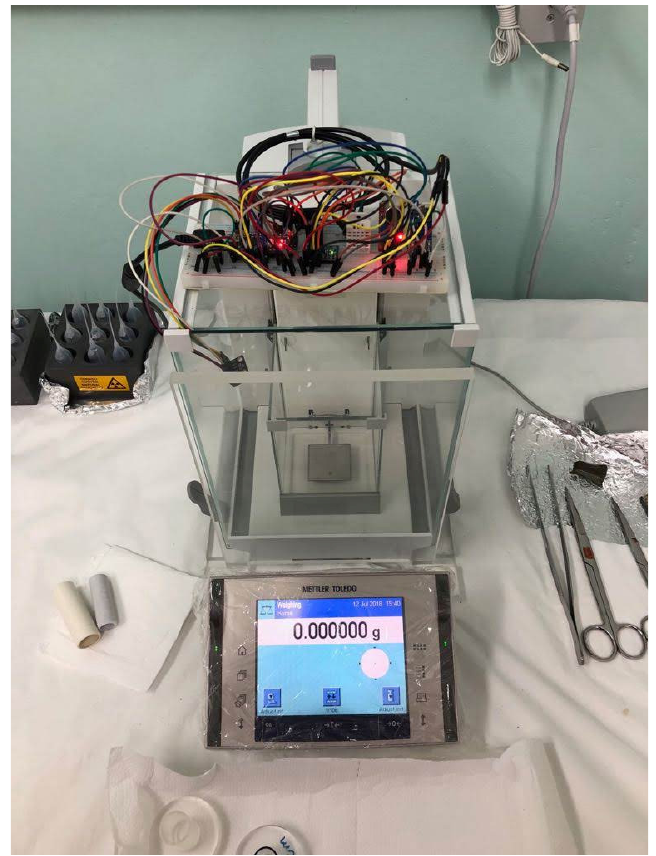
Figure 4. Experimental set-up used for